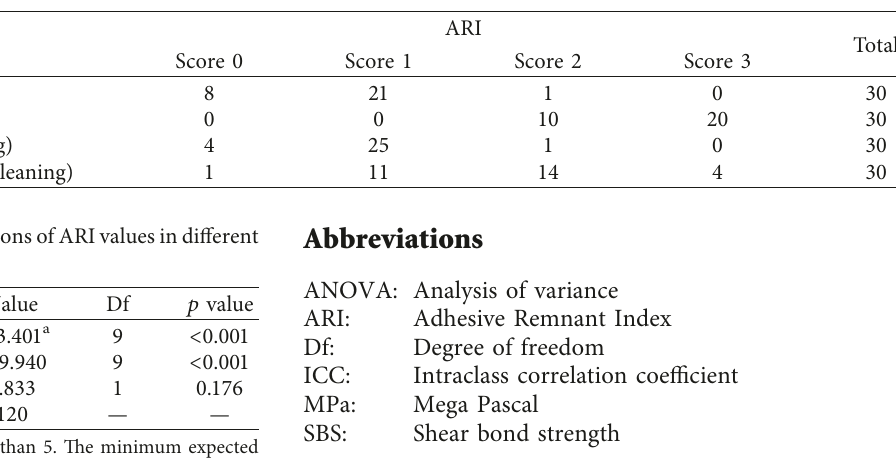
Appendix 1: Table showing intraclass correlation coefficient (ICC) for reliability test. Appendix 2: Table showing test of normality. ( Supplementary Materials )